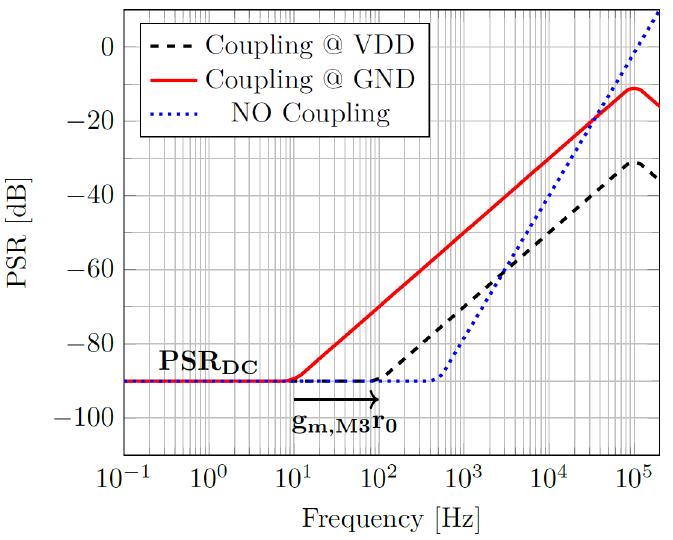
Figure 5. Comparison of a PSR typical shape without coupling capacitor C C (dotted line), with C C connected from V 0 to VDD (dashed line) and GND (solid line). The graph shows that z 1 is moved to higher frequencies by a factor g m,M3 r 0